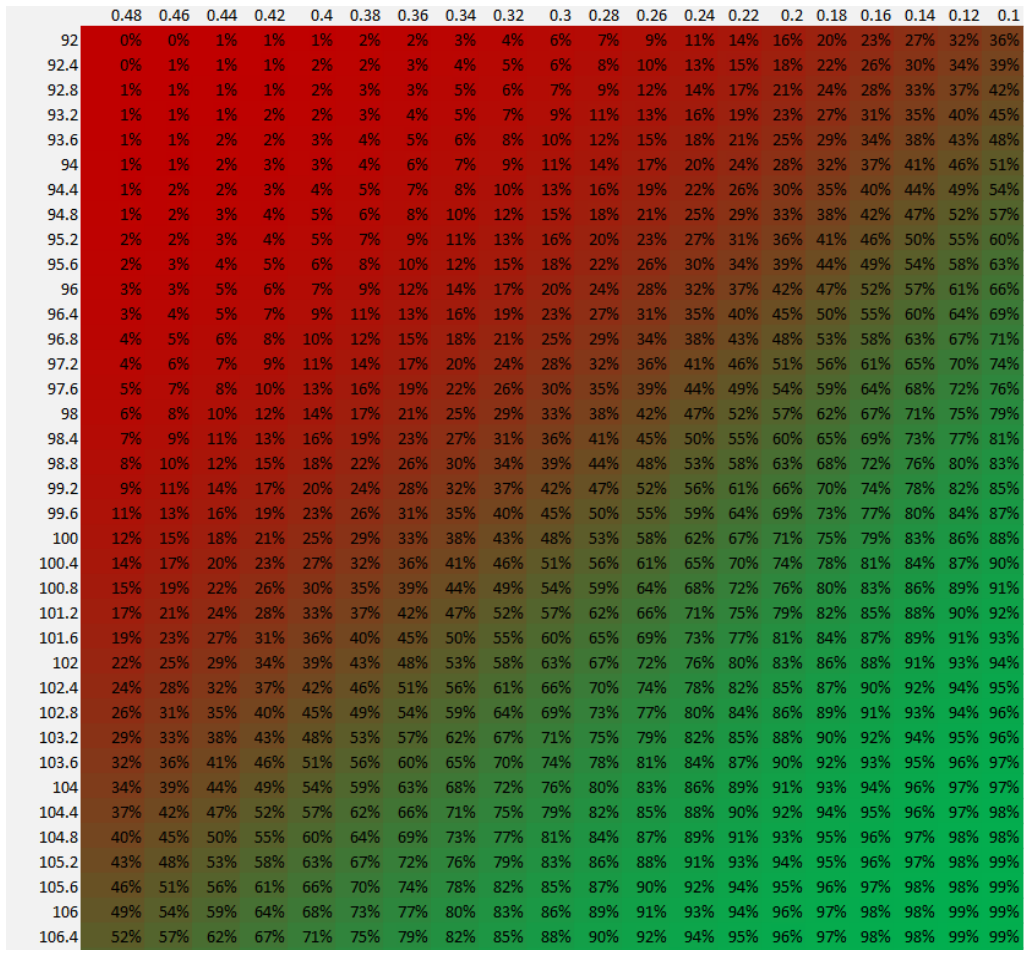
Figure 6. For 2014q1, the projected probability of GDP being in boom state ( d various values of industrial production (82–99) and the ASE realized volatility